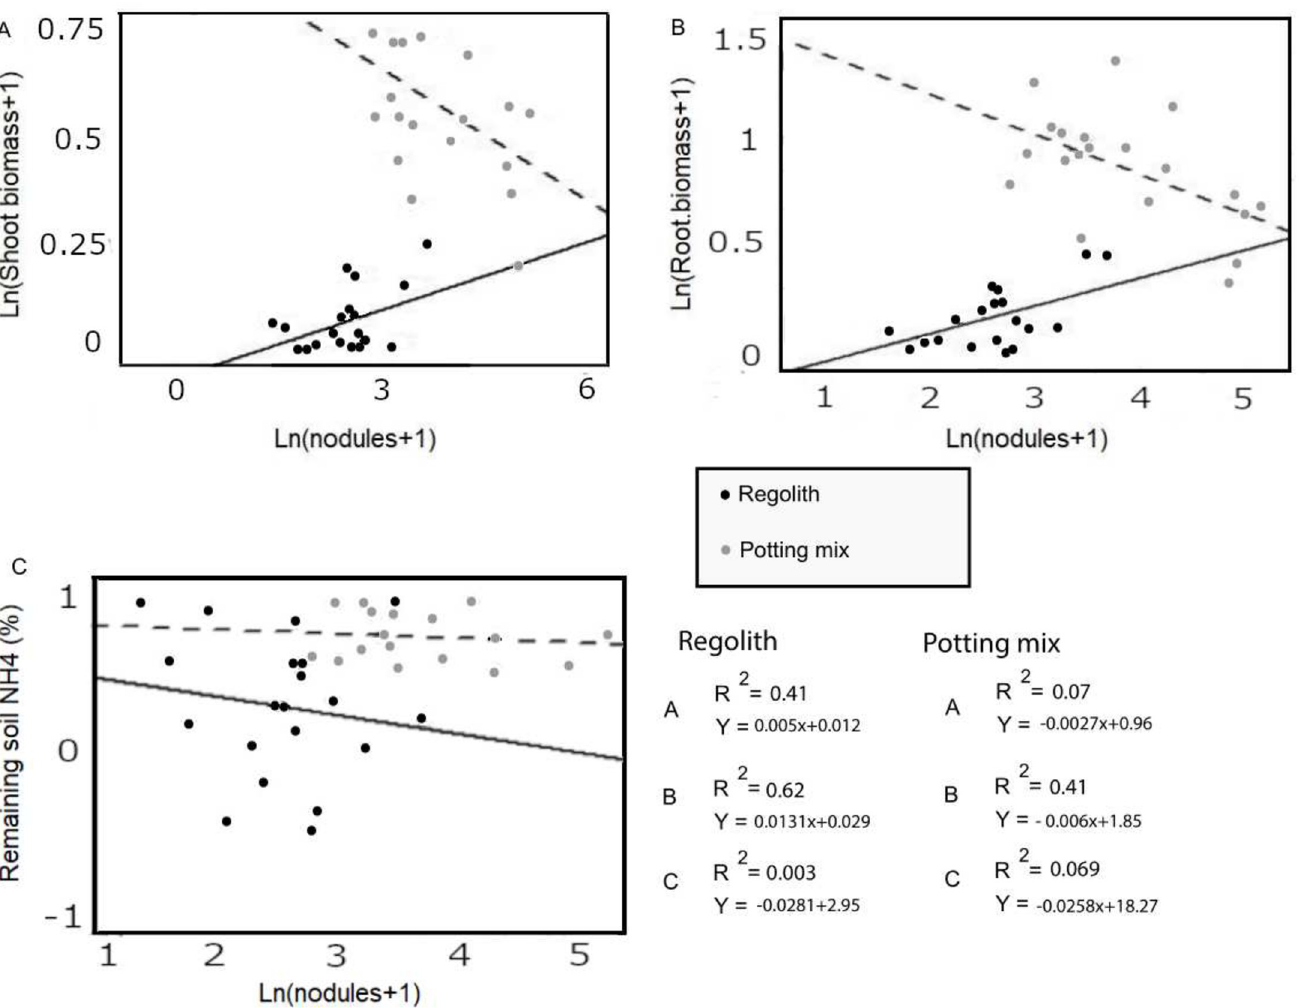
Fig 1. Linear regression of shoot biomass by nodules (A), root biomass by nodules (B) and remaining and added nitrogen in soil by quantity of nodules (C) for either regolith or potting soil. NH 4 was calculated using the pre-experiment sample for each group and creating a percent for each data point. Data were checked for normality; outliers were removed, and the log scale of the data was